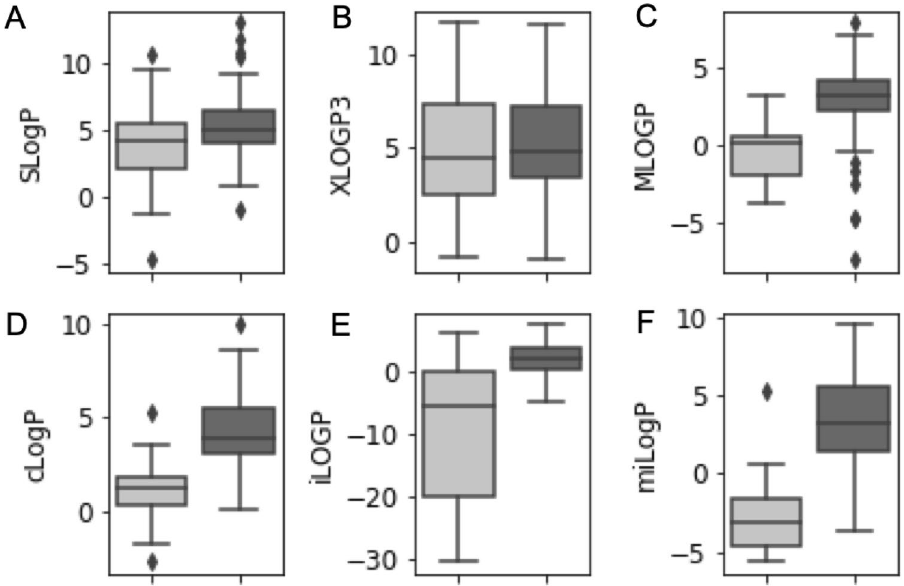
Figure 2. Distribution of LogP values for a test set of fluorescent probes. The boxplots display the distribution of six LogP descriptors calculated for a set of 124 fluorescent probes (25 impermeant probes, light grey and 99 cell permeable probes, dark grey). ( A ) SLogP descriptor. ( B ) XLOGP3 descriptor. ( C ) MLOGP descriptor. ( D ) cLogP descriptor. ( E ) iLOGP descriptor. ( F ) Boxplot of the miLogP descriptor.